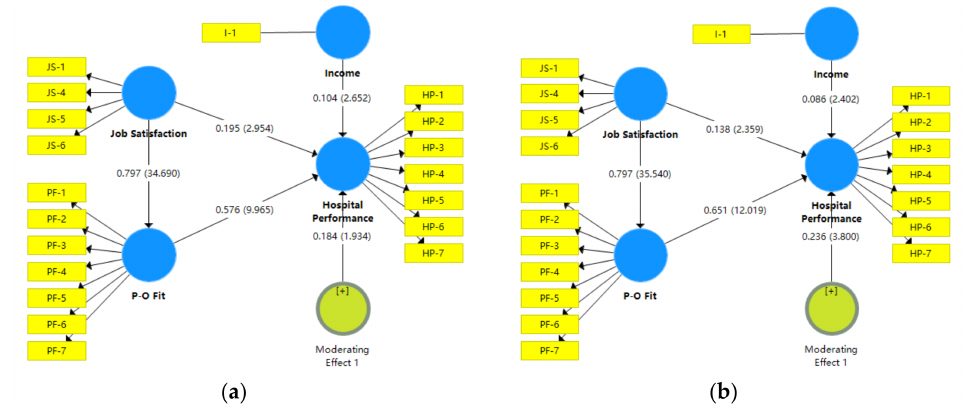
Figure A4. Moderating e ff ects of income (two items deleted from job satisfaction scale). ( a ) Moderating e ff ect of income on “Job satisfaction-Hospital performance”: t = 1.934, p = 0.053; ( b ) Moderating e ff ect of income on “P-O Fit - > Hospital performance”: t = 3.800, p <